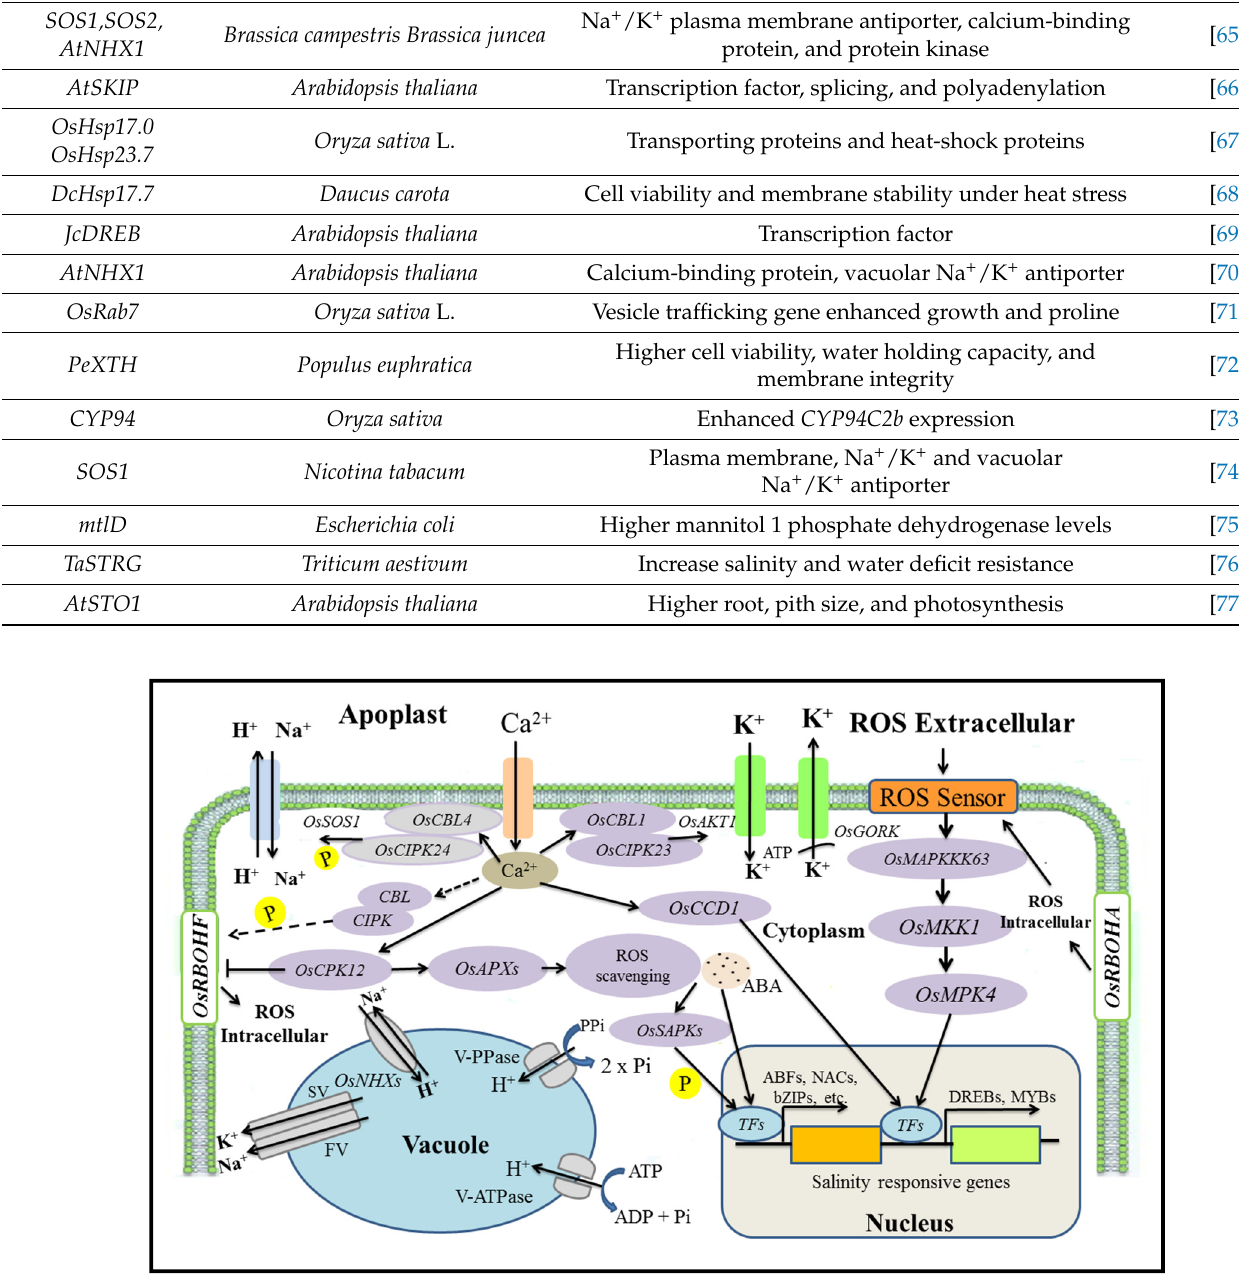
Figure 3. Signaling pathways in rice under salt stress. MicroRNAs and small interfering RNA (siRNAs) could play a significant role in the abiotic stress responses of plants. However, post-transcriptional gene regulation has a significant impact on plant salinity resistance [78]. It has been observed that miRNAs are sensitive to biotic as well as abiotic stress. Plants face various environmental abiotic stresses such as drought, salinity, and cold. The overexpression of miR402 is induced by these environmental stresses. Figure 4 shows the post-transcriptional regulation of plant salt stress-responsive genes mediated by miRNA as studied in Arabidopsis thaliana and Oryza sativa to determine the significant role of miRNA in salt stress